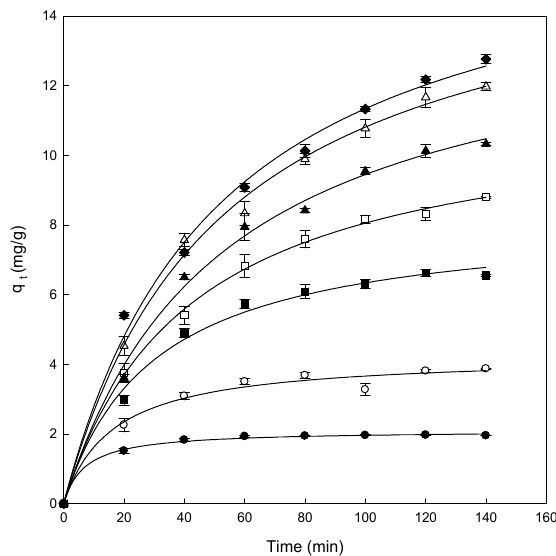
Figure 3. Effect of contact time between eggshell at different concentrations of Direct Blue 78 of 25 Figure 3. E ff ect of contact time between eggshell at di ff erent concentrations of Direct Blue 78 of 25 mg / L mg/L ( ● ), 50 mg/L ( ○ ), 100 mg/L ( ■ ), 150 mg/L ( □ ), 200 mg/L ( ▲ ), 250 mg/L ( Δ ), and 300 mg/L ( ♦ ). ( • ), 50 mg / L ( ), 100 mg / L ( (cid:4) ), 150 mg / L ( (cid:3) ), 200 mg / L ( (cid:78) ), 250 mg / L ( ∆ ), and 300 mg / L ( (cid:7) ). (cid:35)